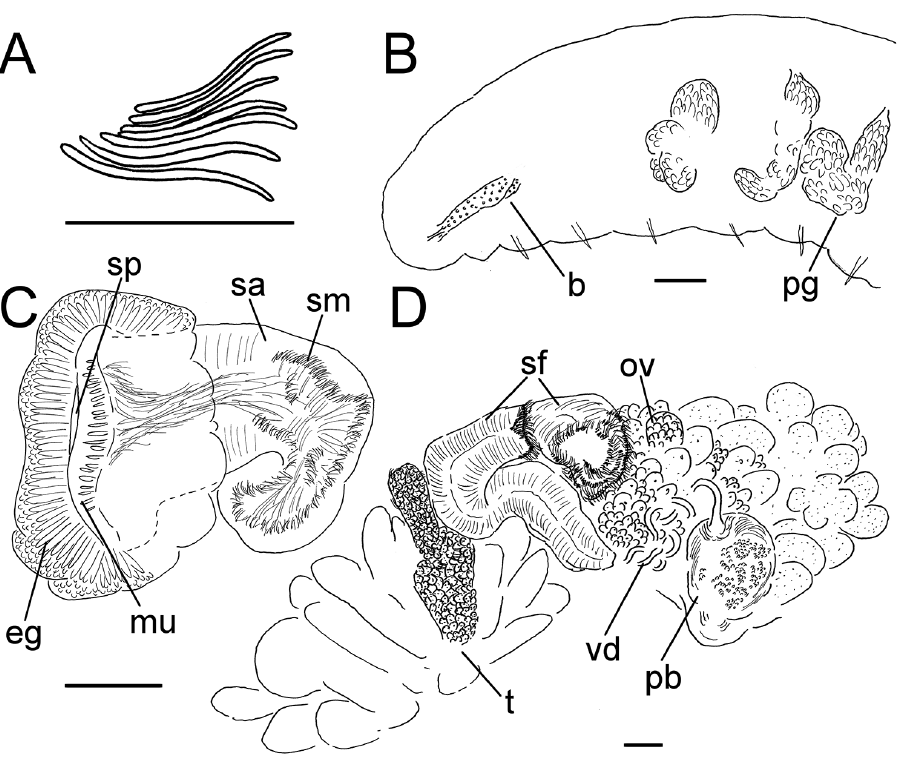
Figure 5. Lumbricillus latithecatus sp. n. A Chaetal bundle B Anterior body C Spermatheca D Other genitalia. Abbreviations under general notes. Scale bars: 100